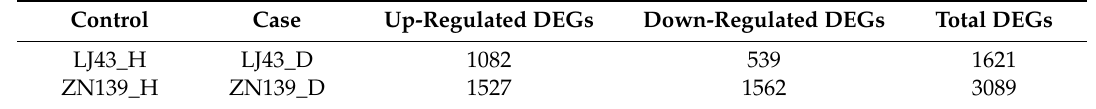
Table 3. List of total DEGs in case-control study 1